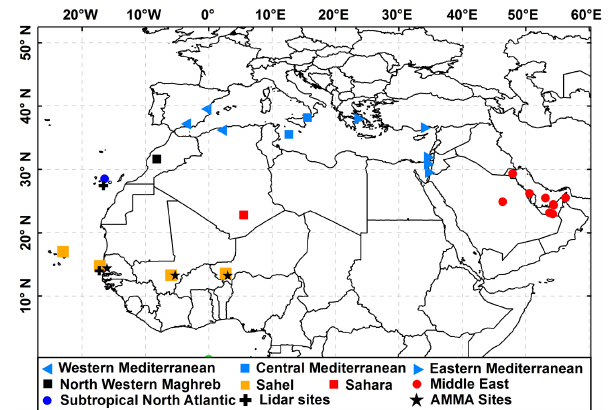
Figure 2. Localization of the AERONET stations, grouped by re- gions, lidar sites and PM 10 monitoring stations. AERONET regions correspond to: (1) Western Mediterranean, (2) Central Mediter- ranean, (3) Eastern Mediterranean, (4) Middle East (5) Sahara, (6) Sahel and (7) subtropical North